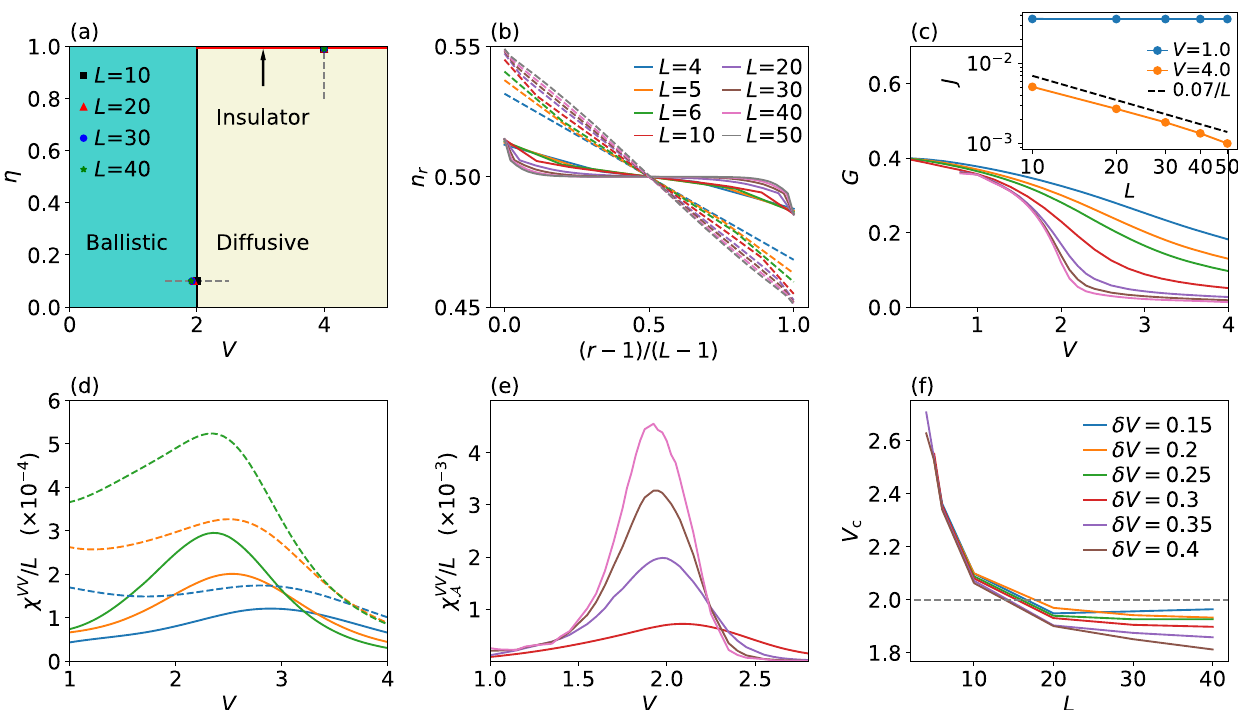
Fig. 2 Results for the fermionic chain. a Sketch of the known phase diagram, showcasing a ballistic, diffusive, and insulating regimes. The symbols give the location of the peaks in e for different system sizes. b Comparison of the real space occupations between the ballistic phase at V = 1.0 (continuous) and the diffusive at V = 4.0 (dashed). Figures b – f are obtained for η = 0.1. Figures b – e use the color code given in b . c G versus V for different system sizes. Inset shows the current ’ s dependence with L for the different regimes, with the dashed line being a guide for the eyes delineating the diffusive behavior. d Comparison of af fi nity (continuous) and fi delity (dashed) susceptibilities per degree of freedom obtained by exact diagonalization for δ V = 0.01. e χ VV A = L for δ V = 0.2 obtained via MPS. f Critical coupling V c , measured as maximum of χ VV A vs L for different perturbation